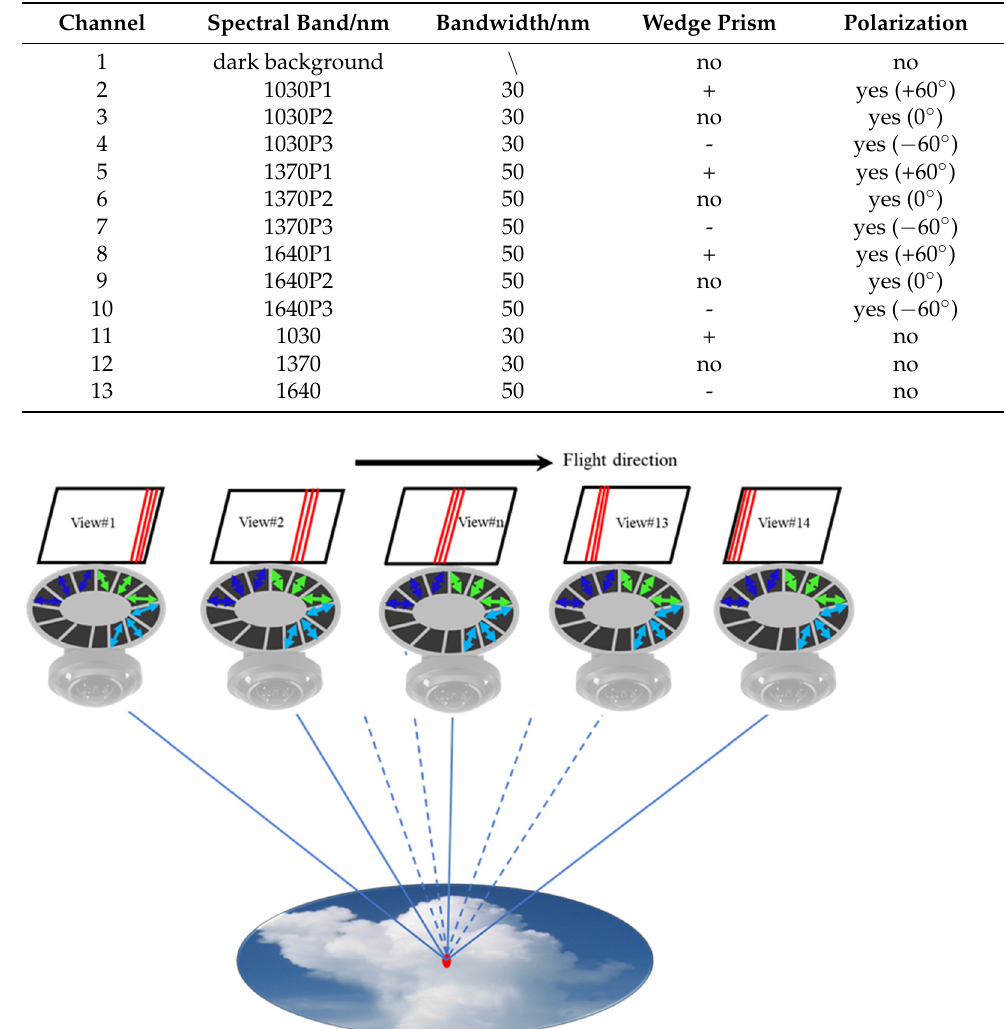
Figure 3. Schematic diagram of shortwave infrared multi-angle polarization observation capability of MAPI. Along the flight direction, a total of 14 observations were made to the same target, and each observation corresponds to a different area on the detector (as shown by the red line in the square detector). The gray disc represents the filter wheel, consisting of the filters and polarizers of 13 channels, where the arrows indicate the transmitting axis direction of the polarizers. Below the filter wheel is an optical lens with a large field of